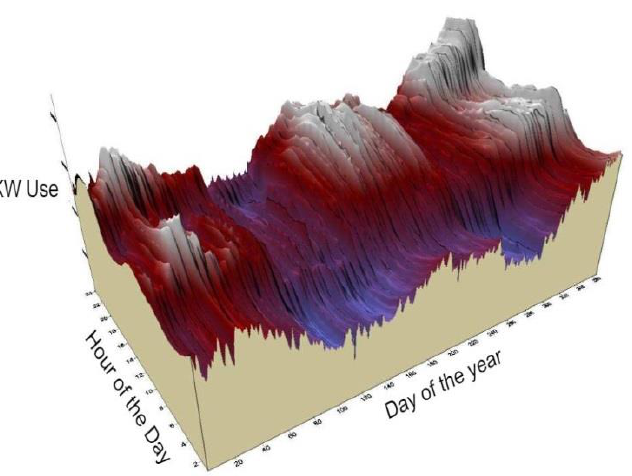
Figure 1. Typical load graph for a remote area (Loads: minimum, average, and maximum values) [9].